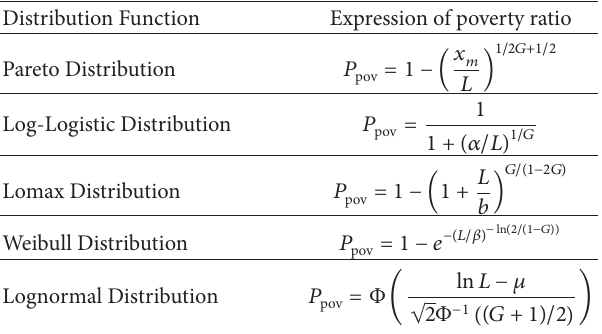
Table 2: Poverty ratio of the five Distribution Functions.